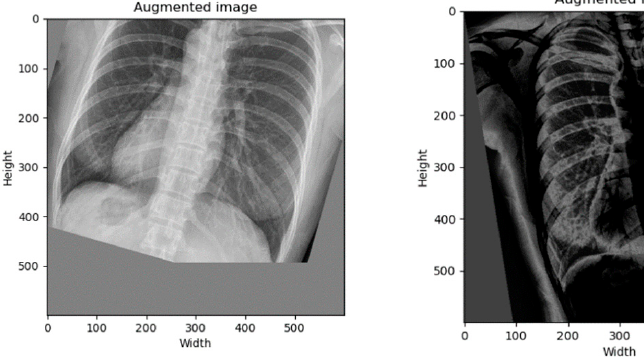
Figure 4. Augmented images were generated randomly using the RandAugment technique.